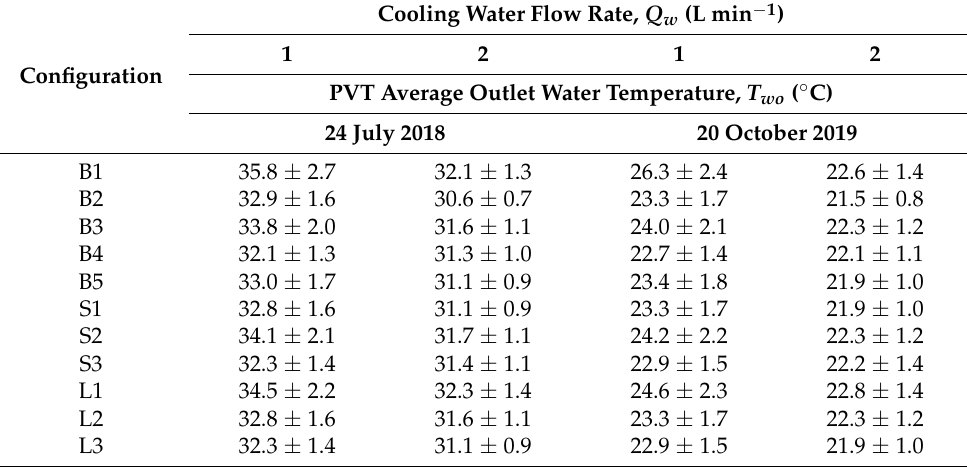
Table A5 shows the effect of the PVT module configuration on the temperature of the cooling water exiting the module. The inlet water temperatures are 28.7 ◦ C and 20 ◦ C on are not included as implementing cooling on that day did not result in increased permeate production for the PVT-RO system. Table A5. Average outlet water temperatures by PVT module configuration and cooling water volumetric flow